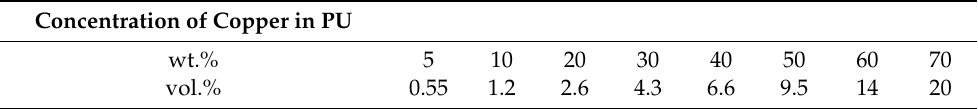
Table 1. Concentration of copper in the polyurethane expressed in percent of weight (wt.%) and percent of volume (vol.%) used in Cu-PU film